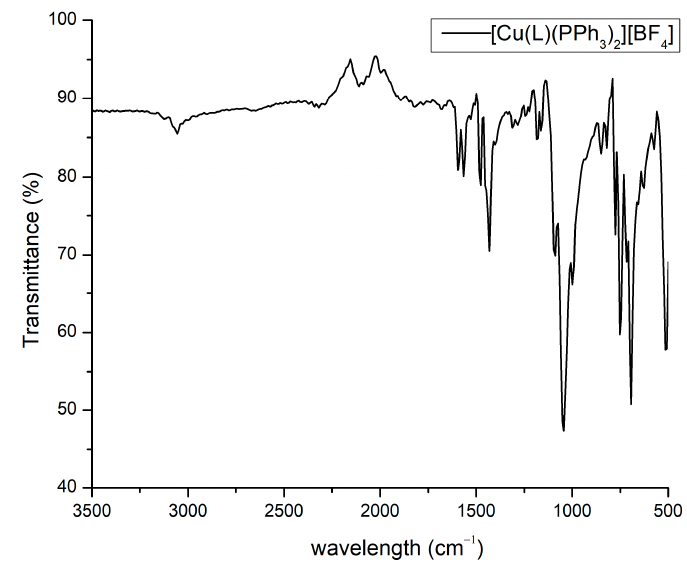
Figure 3. The ATR-IR spectrum of the complex 1 .